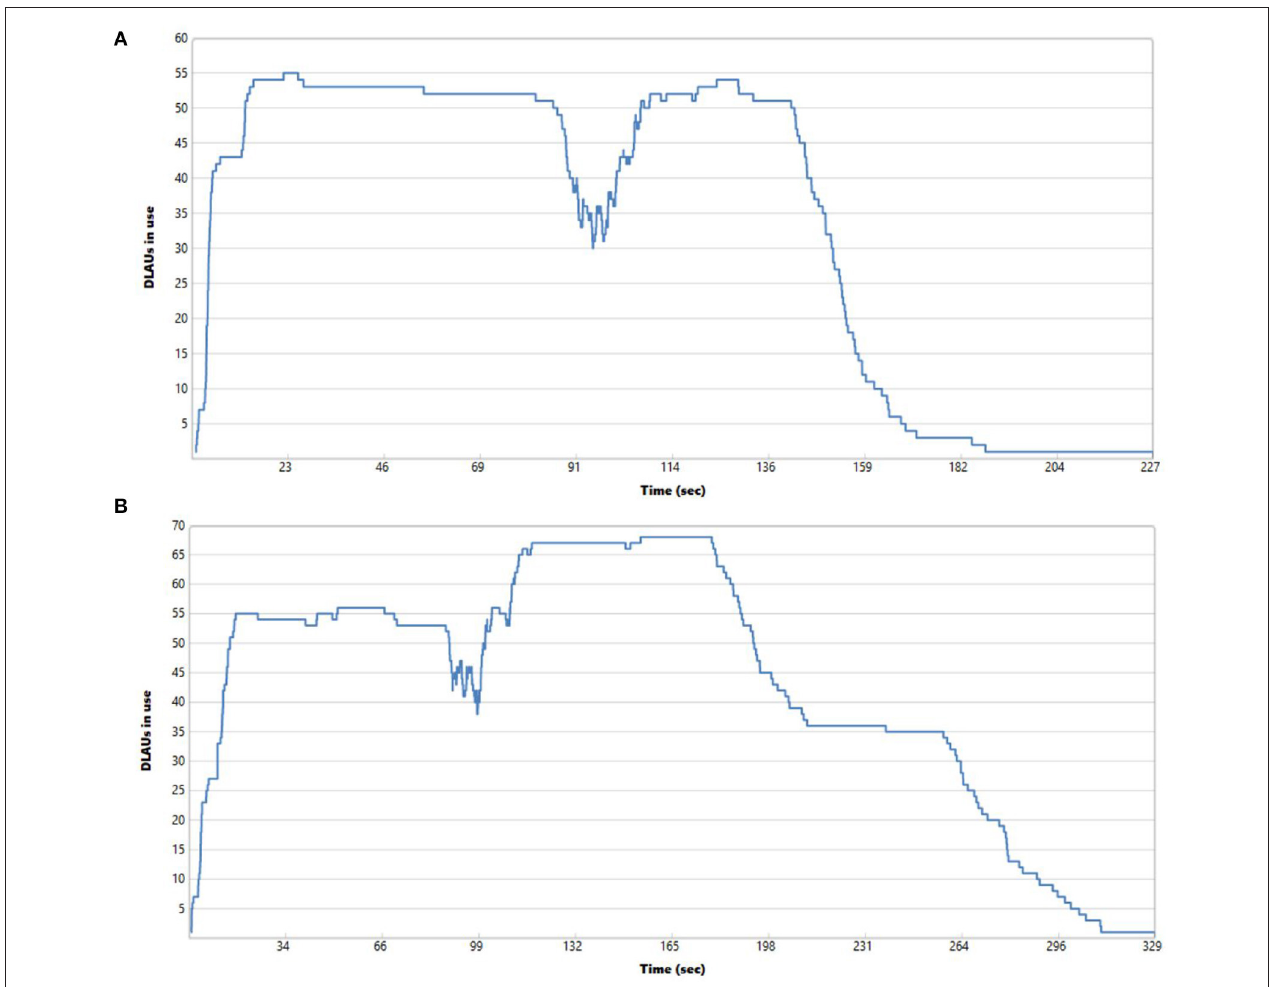
FIGURE 6 | Utilization of Allocation Units (computational units) over time while processing data from four uncompressed (A) and compressed (B) row-oriented files with forward and reverse reads and saving to eight uncompressed (A) and compressed (B) FASTQ files (two files for each of the processed genomes) with 55 AUs (A) and 68 AUs (B)